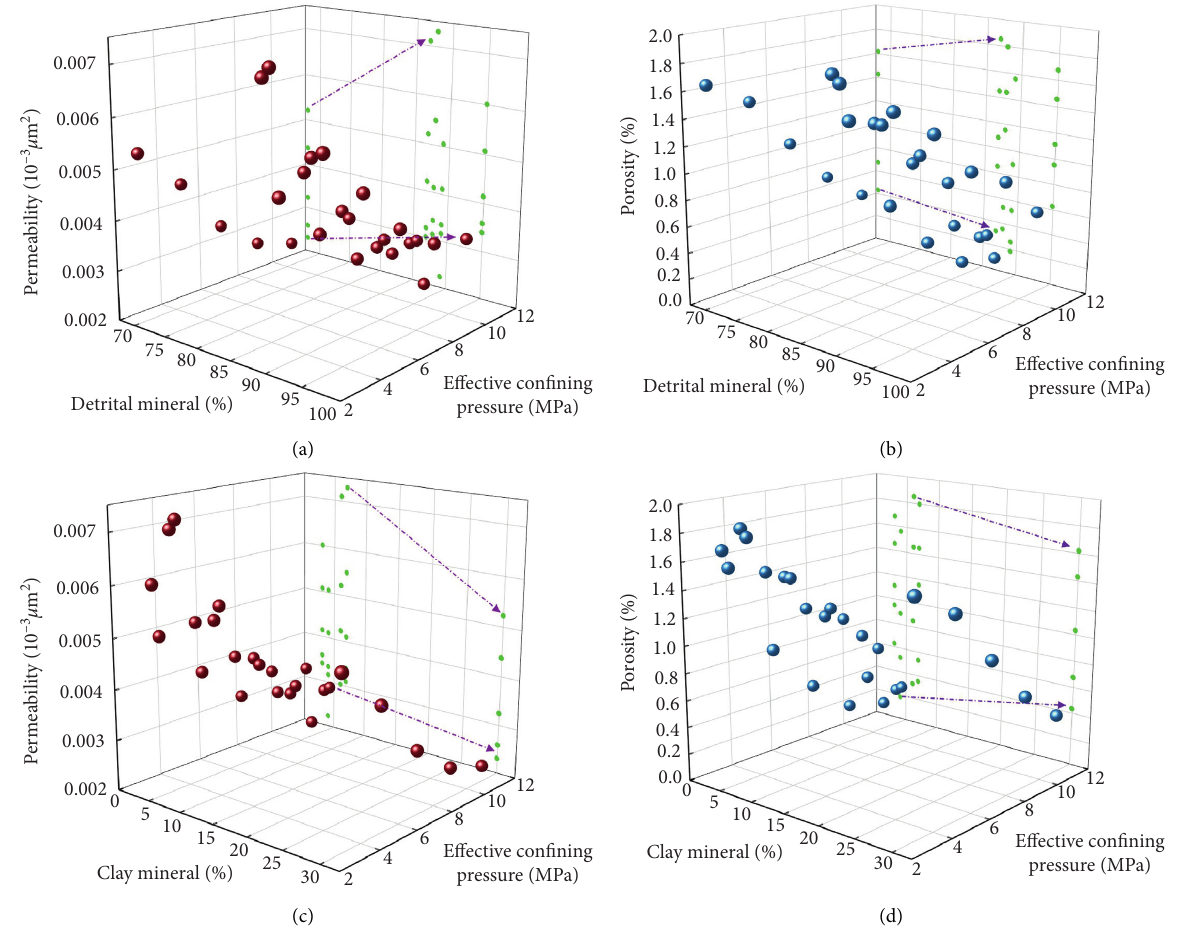
Figure 5: Relationship between mineral components and permeability and